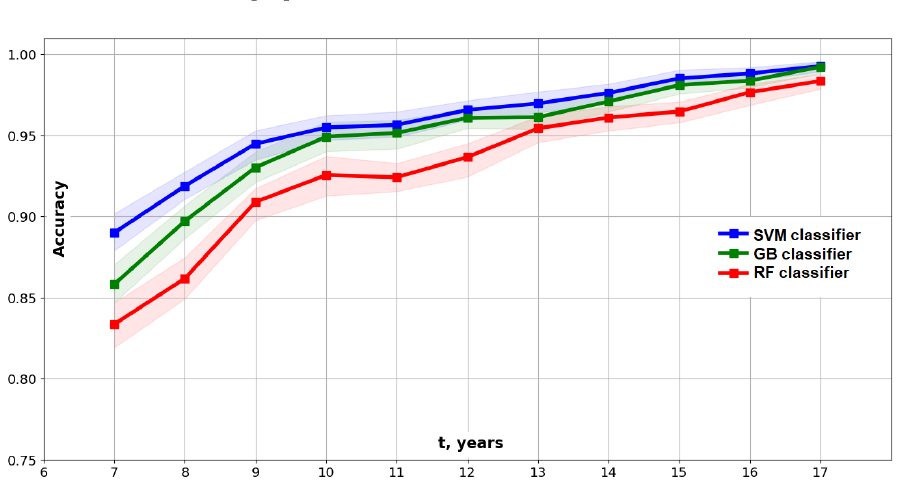
Figure 15. Accuracy of the Type II model: mean values and 95% confidence